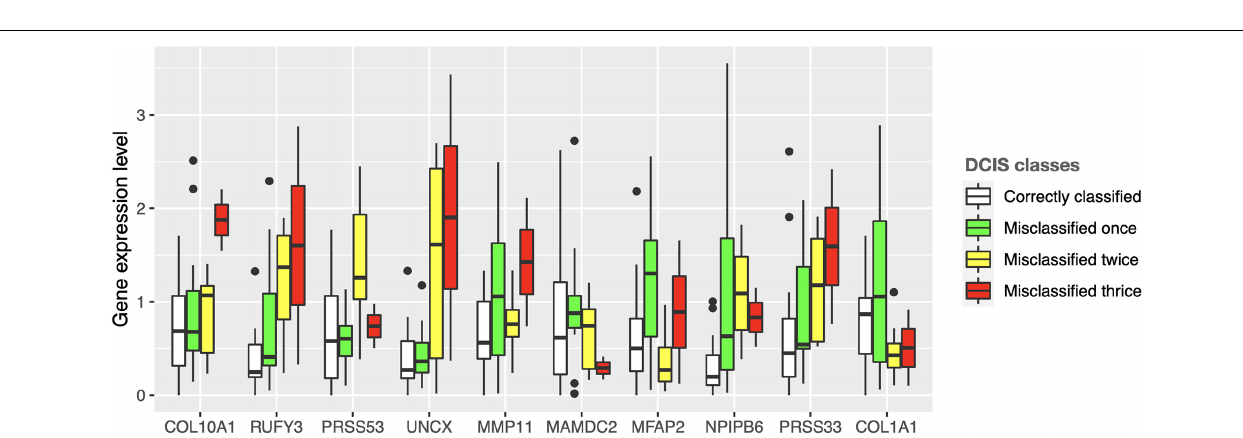
FIGURE 3 | Expression levels of the select 10 genes across the established breast cancer subtypes. Basal, basal-like; HER2, HER2-enriched; LumA, luminal A; LumB, luminal B; Normal, normal-like.